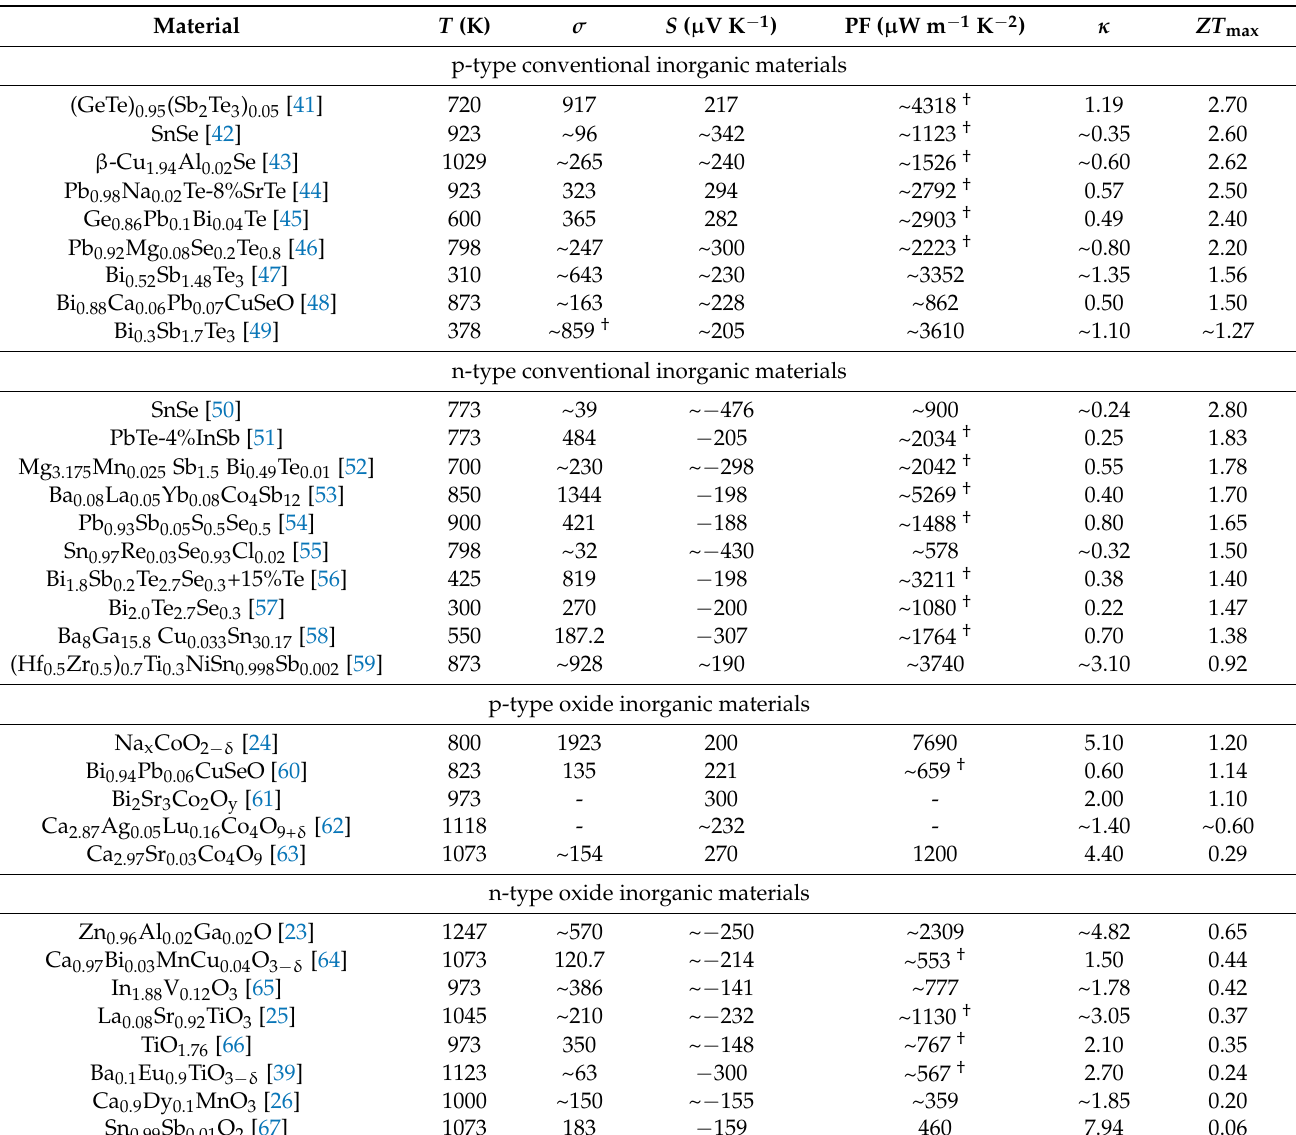
Table 1. Thermoelectric properties of the highest performing inorganic TE materials at a stated temperature ( T ). σ is the electrical conductivity, S is the Seebeck coefficient, PF is the power factor and κ is the thermal conductivity. All values are reported at the maximum of the figure of merit, ZT max . † Calculated from literature